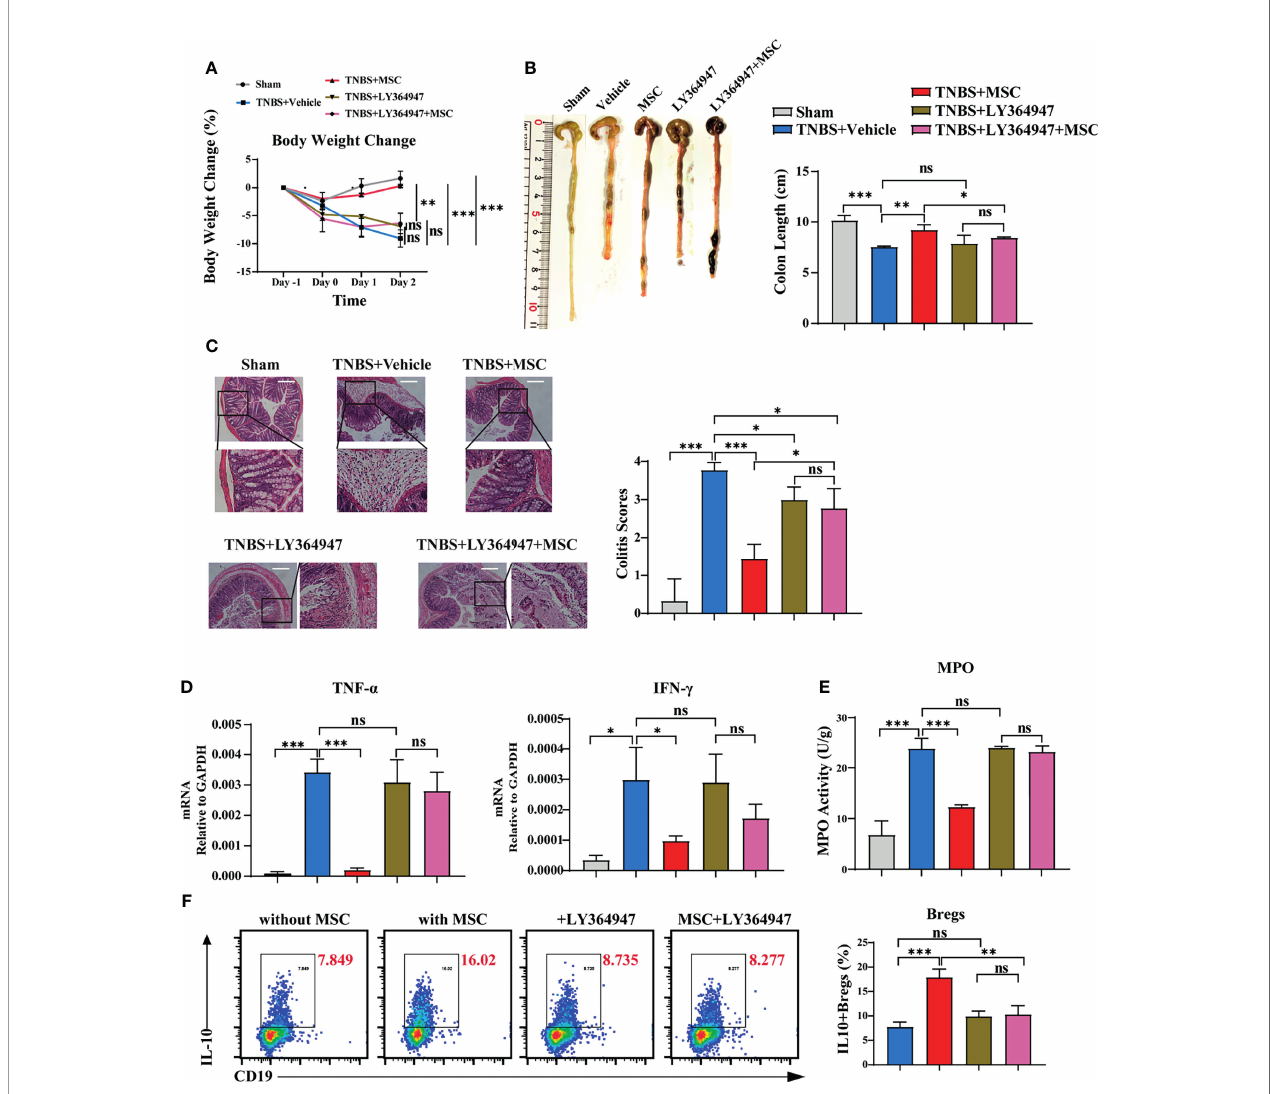
FIGURE 6 | TGF- b R signalling participated critically in MSC-induced IL-10 + Bregs to protect against TNBS-induced colitis. To investigate whether TGF- b R was involved, LY364947 (1 mg/kg) was intraperitoneally administered 3 times a week to block TGF- b R before TNBS enema and MSC administration. The alteration of MSC-mediated protection against colitis was evaluated. (A) Comparison of body weight loss. (B) Representative colon graph and statistical colon length. (C) Histological examination of colon cross sections via H&E staining and histological scoring. (D) Colon tissue was collected, and the expression levels of proin fl ammatory cytokines in colon homogenate were detected by ELISA. (E) Colon tissue was collected, and MPO activity was detected. (F) Peritoneal cells were collected and cultured with or without MSCs in vitro in the presence of LY364947 (10 m M) for 24 h IL-10 + B cells were detected via fl ow cytometry. Data are presented as the means ± SD, n ≥ 3. not signi fi cant (ns) p ≥ 0.05, *p < 0.05, **p < 0.01, ***p < 0.001, ****p <